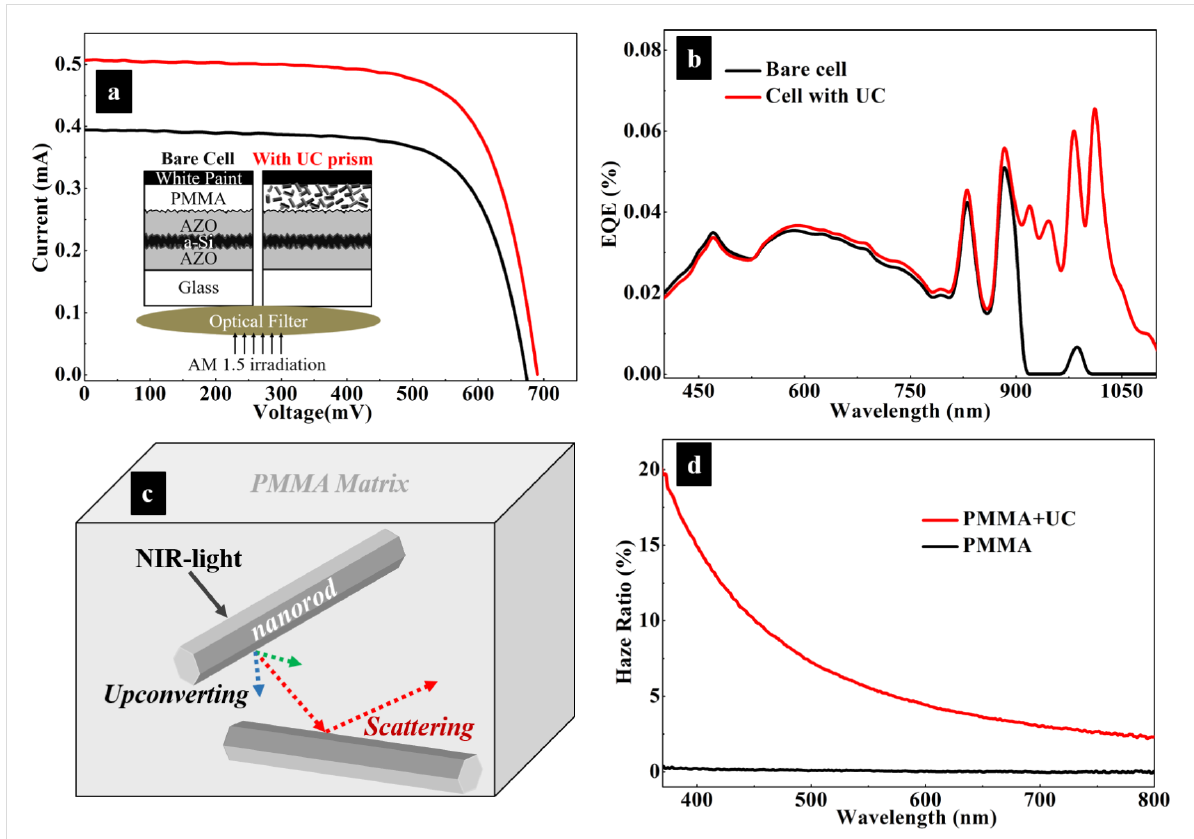
Figure 4: (a) Current–voltage curves and (b) EQE curves of an a-Si:H solar cell with an UC layer compared with the bare cell under AM1.5 solar irra- diation through the optical filter. Inset in (a) is a schematic comparison of the two setups. Schematic diagram (c) of the UC and scattering effects of NaYF 4 :Yb 3+ /Er 3+ prisms in a PMMA matrix. (d) Haze-ratio spectra of PMMA layers on glass with and without UC prisms. The thickness of the PMMA layer is ca. 4.5 μ